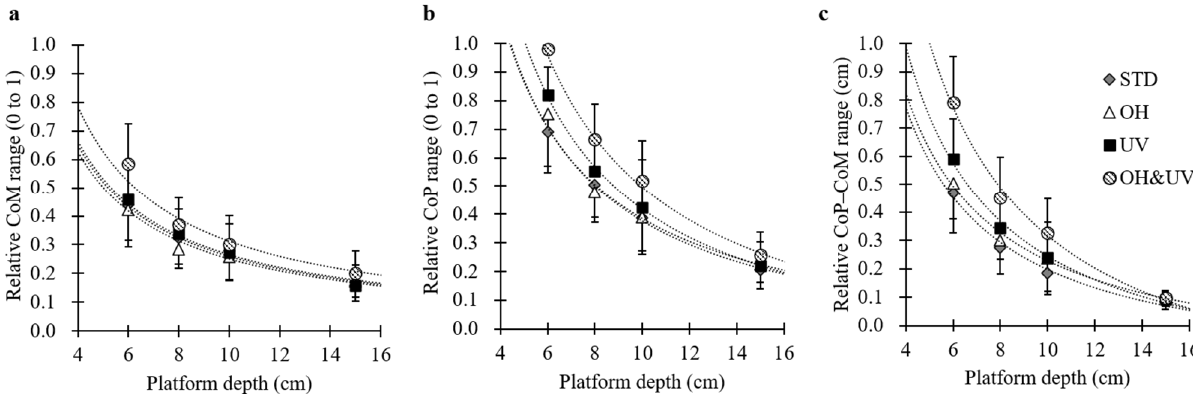
Figure 5. Relative ranges against the platform depth: ( a ) center of mass (CoM), ( b ) center of pressure (CoP), and ( c ) CoP– CoM displacement. Dotted lines show the approximate curves for the reciprocal of the platform depth ( y = a / d + b ). For coefficients of the fitting functions and the significance test of the regression model, see Appendix A.